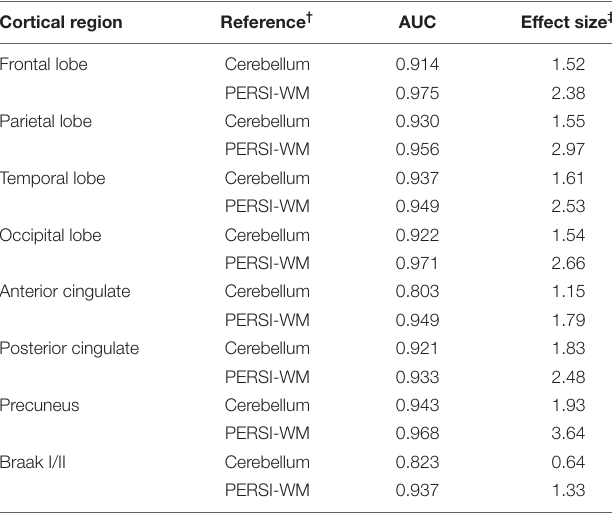
TABLE 3 | Mean standardized uptake value ratio of cortical regions by diagnostic group (Cohort II). Cortical